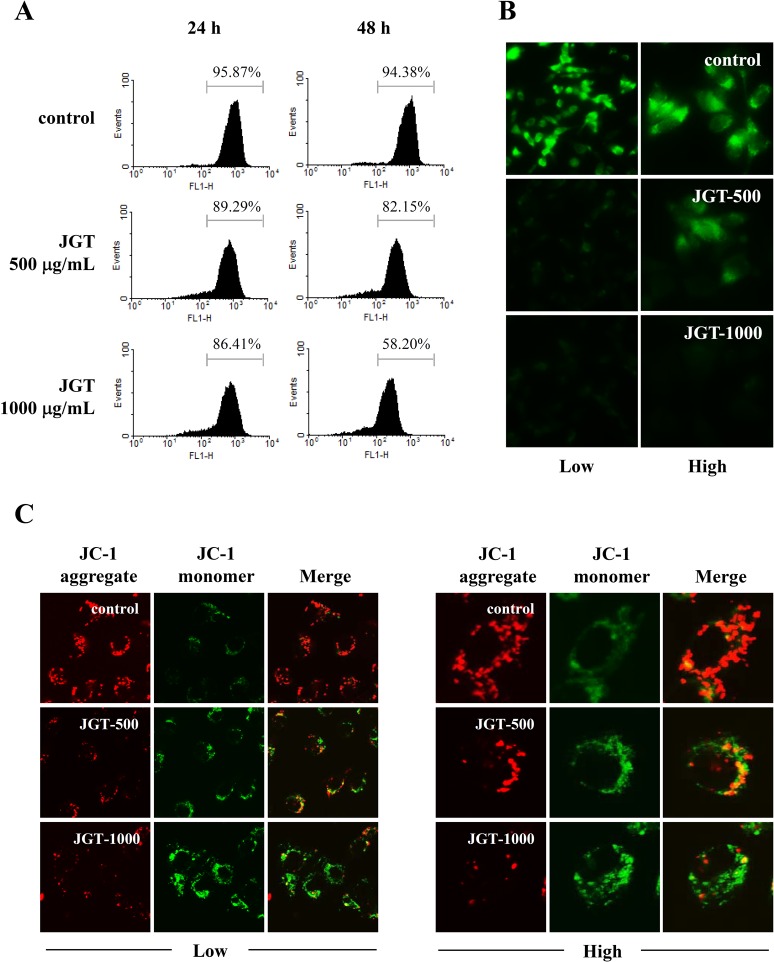
JGT treatment reduces MMP (ΔΨm).
(A) Depolarization of the mitochondrial membrane potential (MMP, ΔΨm) was examined in control and JGT-treated HT1080 cells after staining with rhodamine 123. The percentage of cells with a high MMP (ΔΨm) compared with untreated control cells was calculated using WinMDI 2.8. (B) Rhodamine 123-stained cells were observed under a fluorescence microscope (40× and 200× magnification). (C) The loss of MMP (ΔΨm) was examined using JC-1 staining after treatment with JGT for 48 h (200× and 600× magnification). Data are representative of three independent experiments.